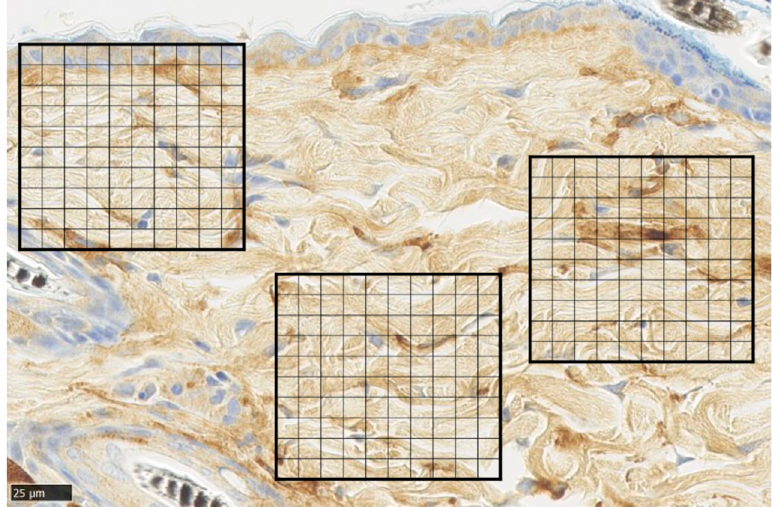
Figure 9. α -smooth muscle actin ( α -SMA) staining. Tissue section of normal skin, divided into 100 equal sections of 100 × 100 µm squares (scale bar 25 µm).